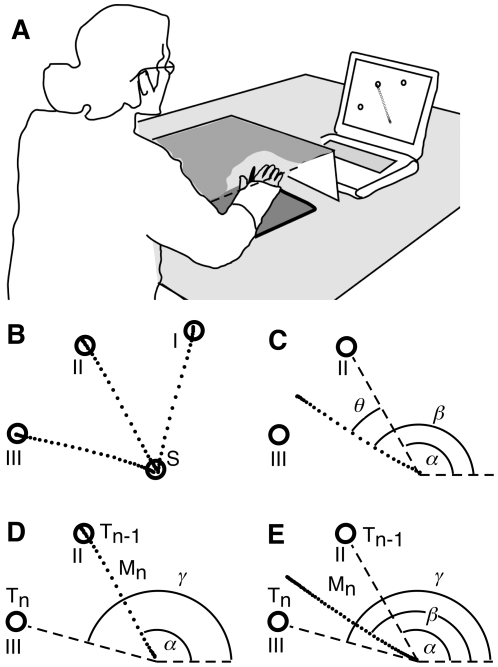
Apparatus and motor tasks.(A) Subject sitting at a table performing the baseline task. The right hand is in a wrist splint with an attached stylus, whose position is recorded by a graphics tablet. Vision of the hand is blocked by a cardboard box. A laptop computer shows the visual targets as circles and the hand's position as a cursor. (B) Sample cursor paths (dots) for three trials (one to each target direction) in the BL condition. Targets I, II, and III are arranged at 75°, 120°, and 165°, respectively, relative to the starting circle (S). (C) Sample cursor path for a trial early in the ROT condition. Target II appears (direction α ) and the subject's hand moves in this direction. Due to the imposed 30° CCW rotation, however, the cursor moves along direction β. The angle between the cursor's path and the target's direction is the directional error (θ = β − α). Between trials, this error induces adjustments of the visuomotor map that are reflected in the next movement. (D) Sample path in the OB condition. The subject is remembering that the previously shown target was II (Tn−1; direction α ). The current target (Tn) appears at 165° (direction γ ). The subject makes a movement in direction α . Between trials, the subject holds in memory direction γ for the next movement. (E) Sample cursor path for an early trial in the OB+ROT condition. The subject is remembering that the previously shown target was target II (Tn−1; direction α ). The current target (Tn) appears at 165° (direction γ ). The subject makes a movement in direction α , and memorizes direction γ for the next movement. However, due to the imposed 30° CCW rotation, the cursor's path is in direction β. Between trials, therefore, the subject must also process the directional error (θ = β − α), while holding in memory the target's direction (γ).